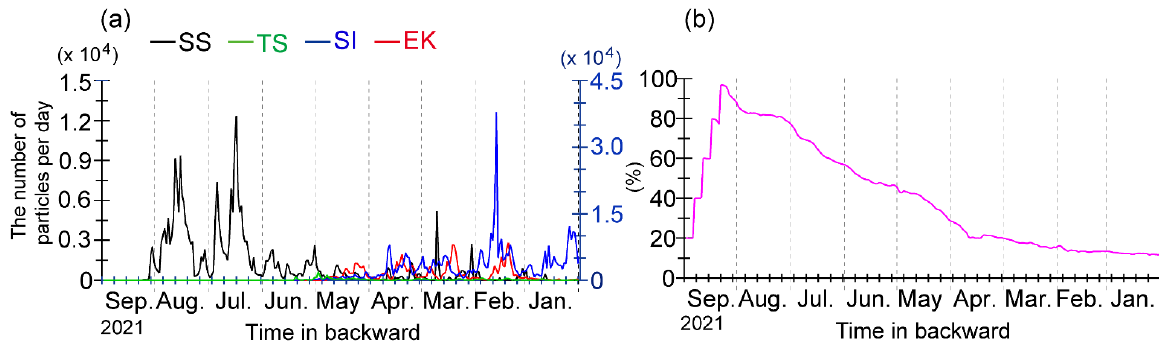
Figure 11. ( a ) The number of particles per day that passed through transect SS (black line), TS (green line), SI (blue line), and EK (red line), the locations of which are denoted in Figure 10a. The left black (right blue) axis corresponded to timeseries of SS, TS, and EK (SI). ( b ) The remaining ratio of particles within the focal region, i.e., the number of particles distributed within the focal region relative to the total number of released particles (1,438,500).